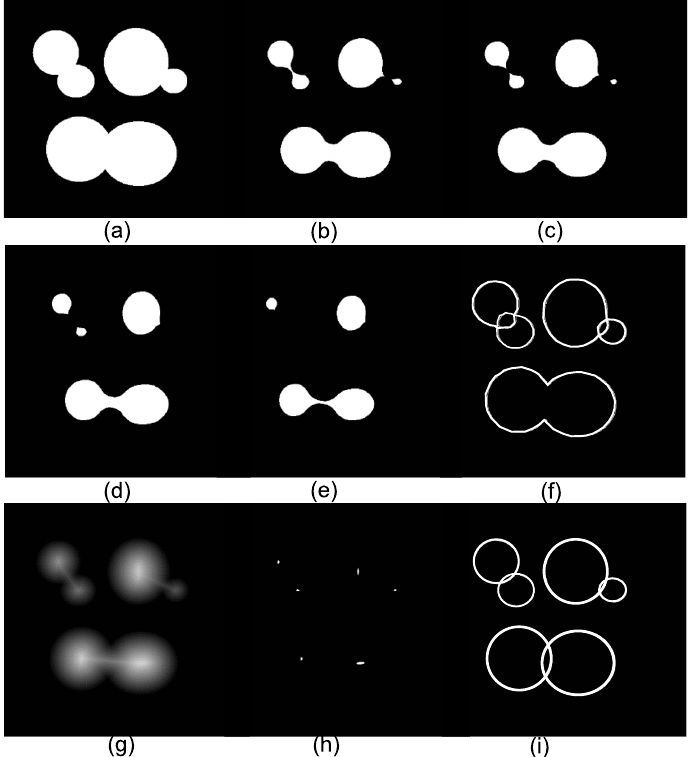
Figure 3. Connected components in viscous lattices. ( a ) The original set; ( b – e ) eroded images by disks of sizes 20, 22, 27, and 36; ( f ) connected components for viscosity λ = 22; ( g ) distance function; ( h ) ultimate eroded components for viscosities (sizes) 25, 34, 45, 64, 66, and 68; and ( i ) connected components in the viscous lattice